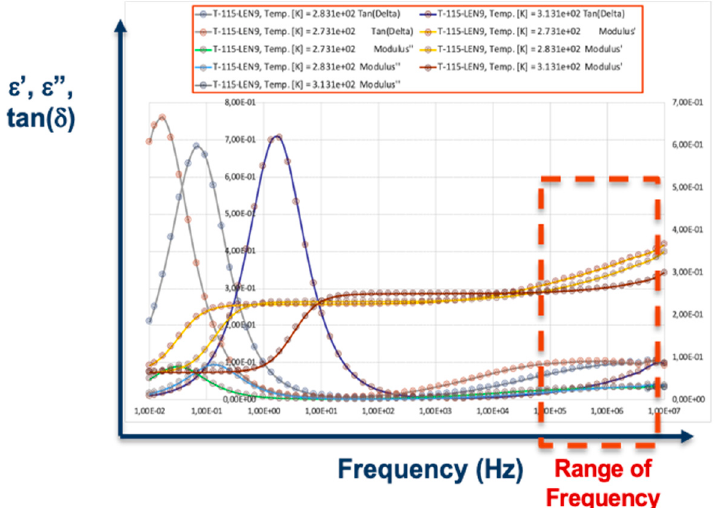
Figure 10. DETA dielectric testing was developed with 3 different temperatures for prototype LEP used in this work, valid for high frequencies up to 10 MHz but not contemplating mechanical properties definition.